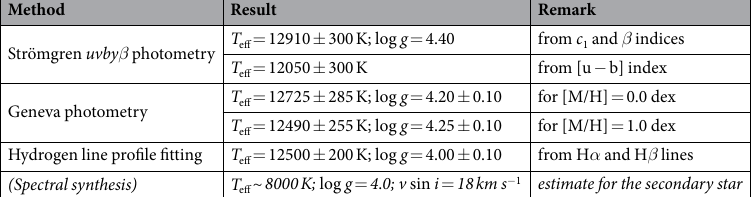
Table 1. Atmospheric parameters of HD 66051, as derived from different methods. The first three rows list parameters of the primary component, the bottom row (highlighted by italic font) indicates an estimate for the secondary star.